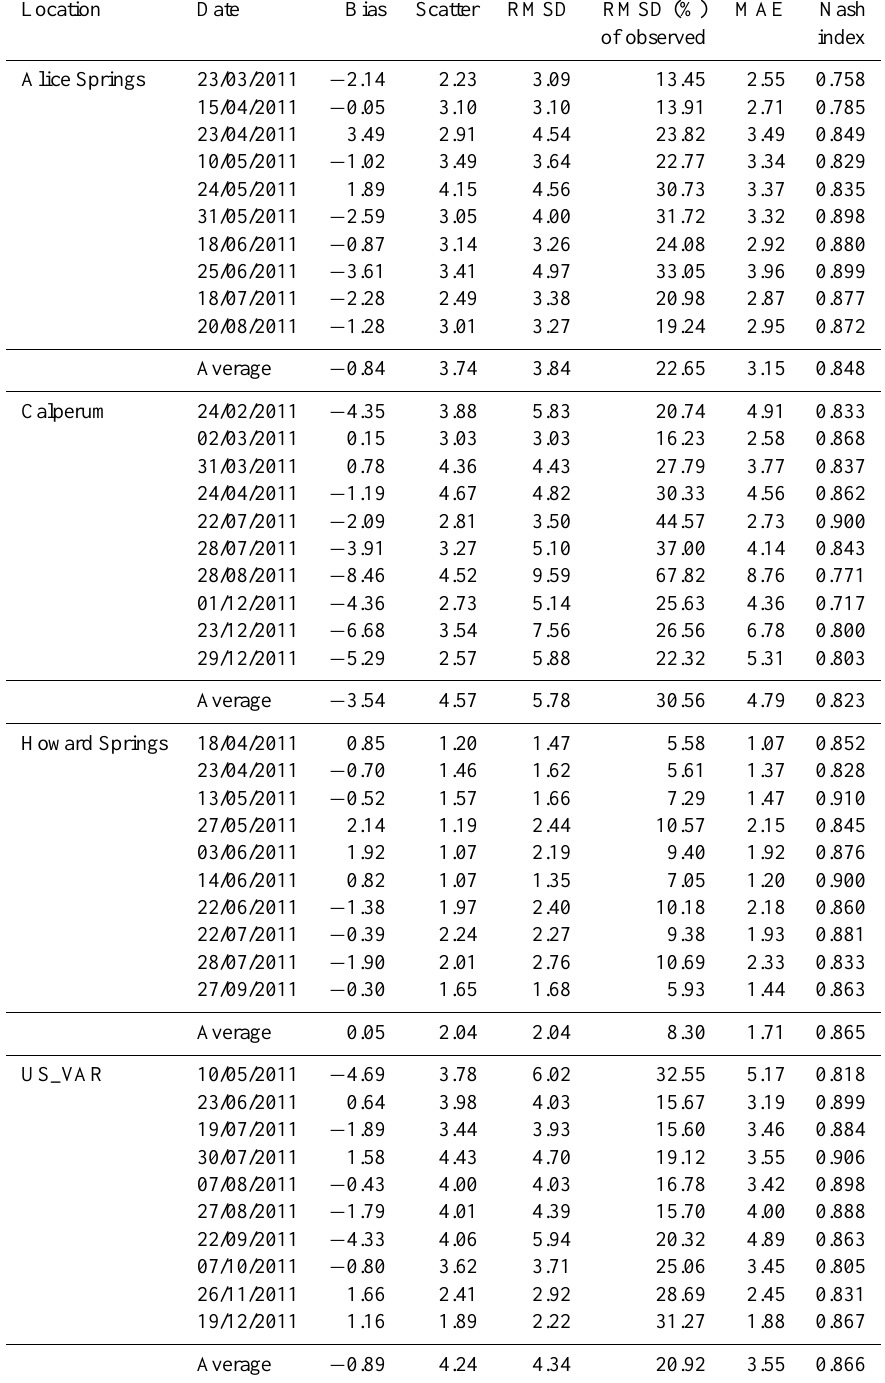
Table 8. Daily simulation accuracy and average site simulation accuracy for T air 50 m . Bias, scatter, RMSD and MAE are expressed in degrees Celsius. Nash index is